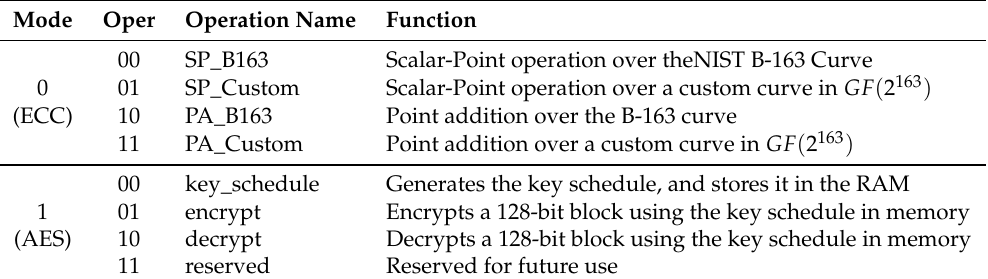
Table 1. ECC163AES128 modes and